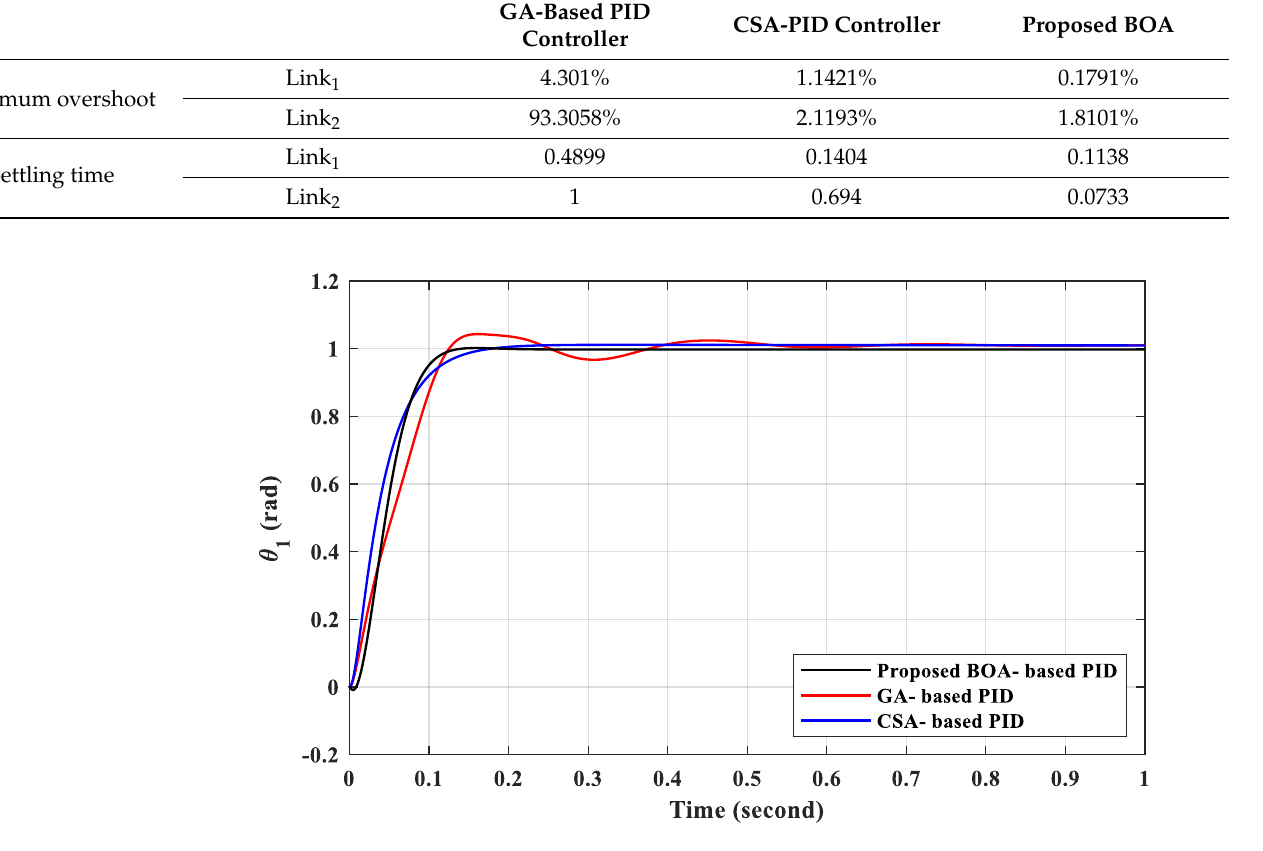
Figure 5. The output response of link1 in the case of Scenario 1.